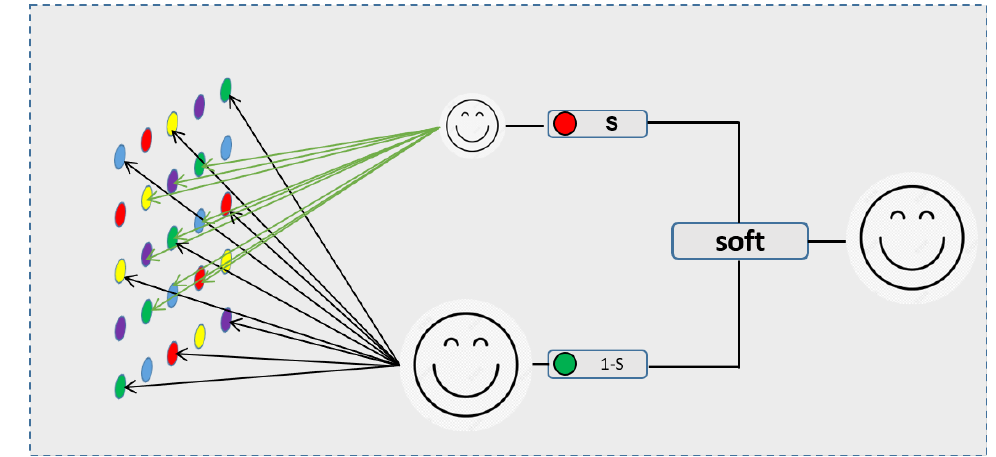
Figure 4. SSAC intuitive map, including convolution with different atrous